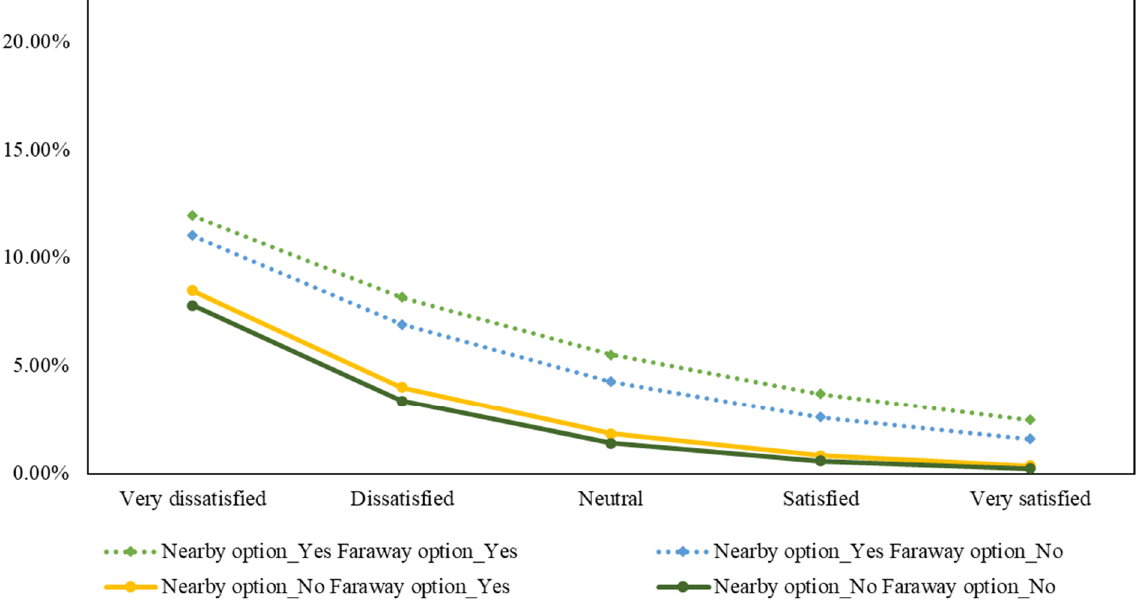
Figure 9. Probabilities of migration intention in female citizens, aged 31–40, college level, based on air quality satisfaction, perceived availability of nearby and faraway migration alternatives.